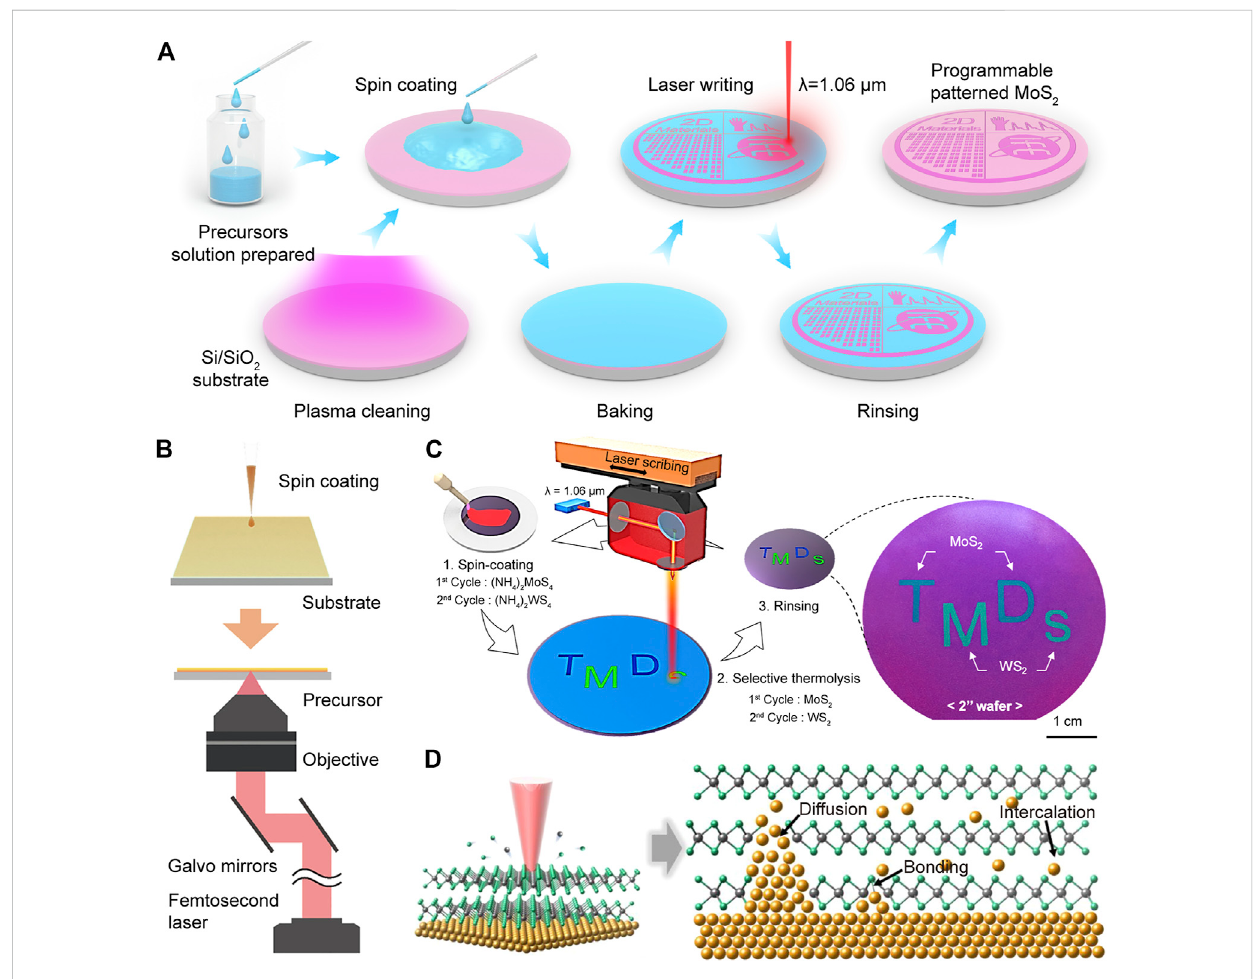
FIGURE 2 Bottom-up synthesis methods. (A) Flow diagram of direct laser writing, a method for the laser-directed synthesis of MoS 2 on the SiO 2 /Si wafer (Xu et al., 2021a) (Copyright 2021, Elsevier). (B) Schematic of MoS 2 synthesized by femtosecond laser (Xu et al., 2022) (Copyright 2022, American Chemical Society). (C) Schematic of the layer synthesis of MoS 2 – WS 2 heterostructure (Park et al., 2020a) (Copyright 2020, American Chemical Society). (D) Schematic of Au-doped MoS 2 (Huo et al., 2021) (Copyright 2021, American Chemical